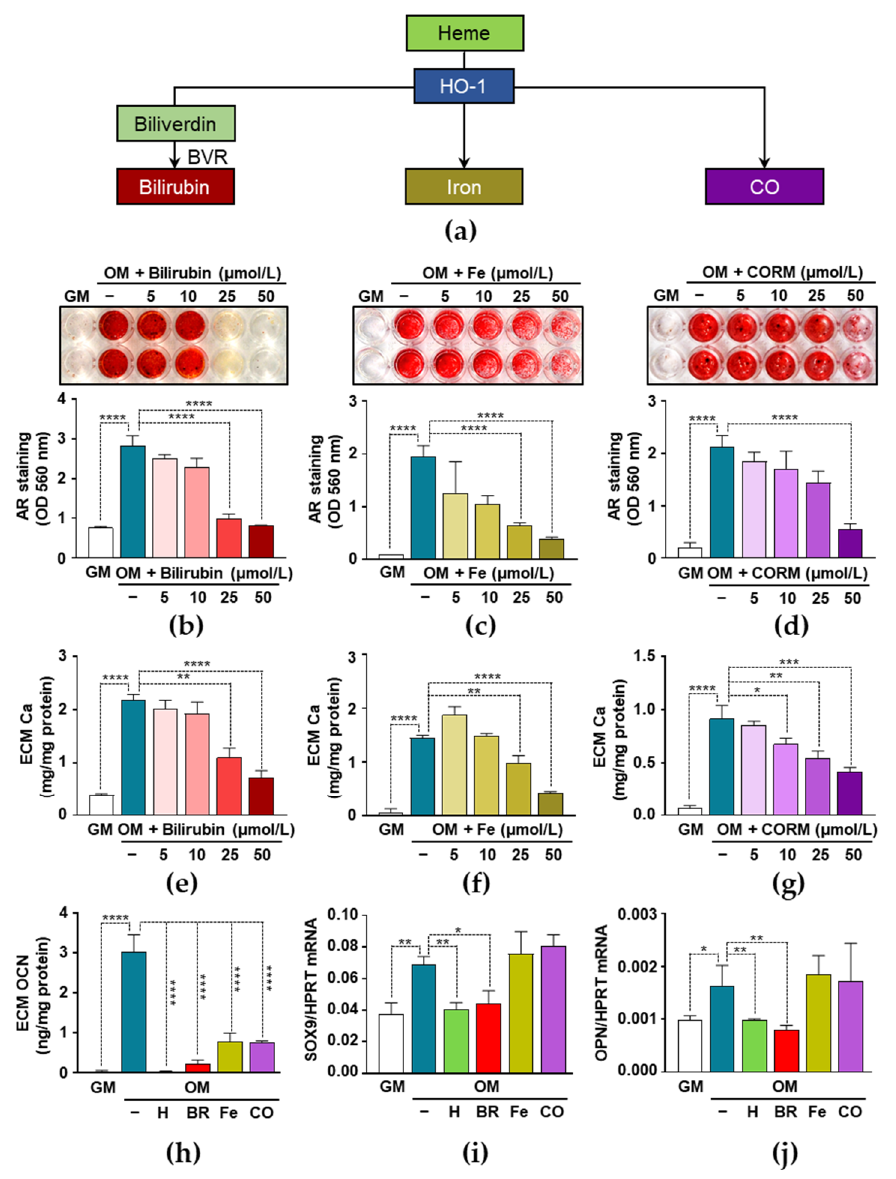
Figure 5. The effect of bilirubin, iron, and CO on the calcification of VICs. ( a ) Schematic of